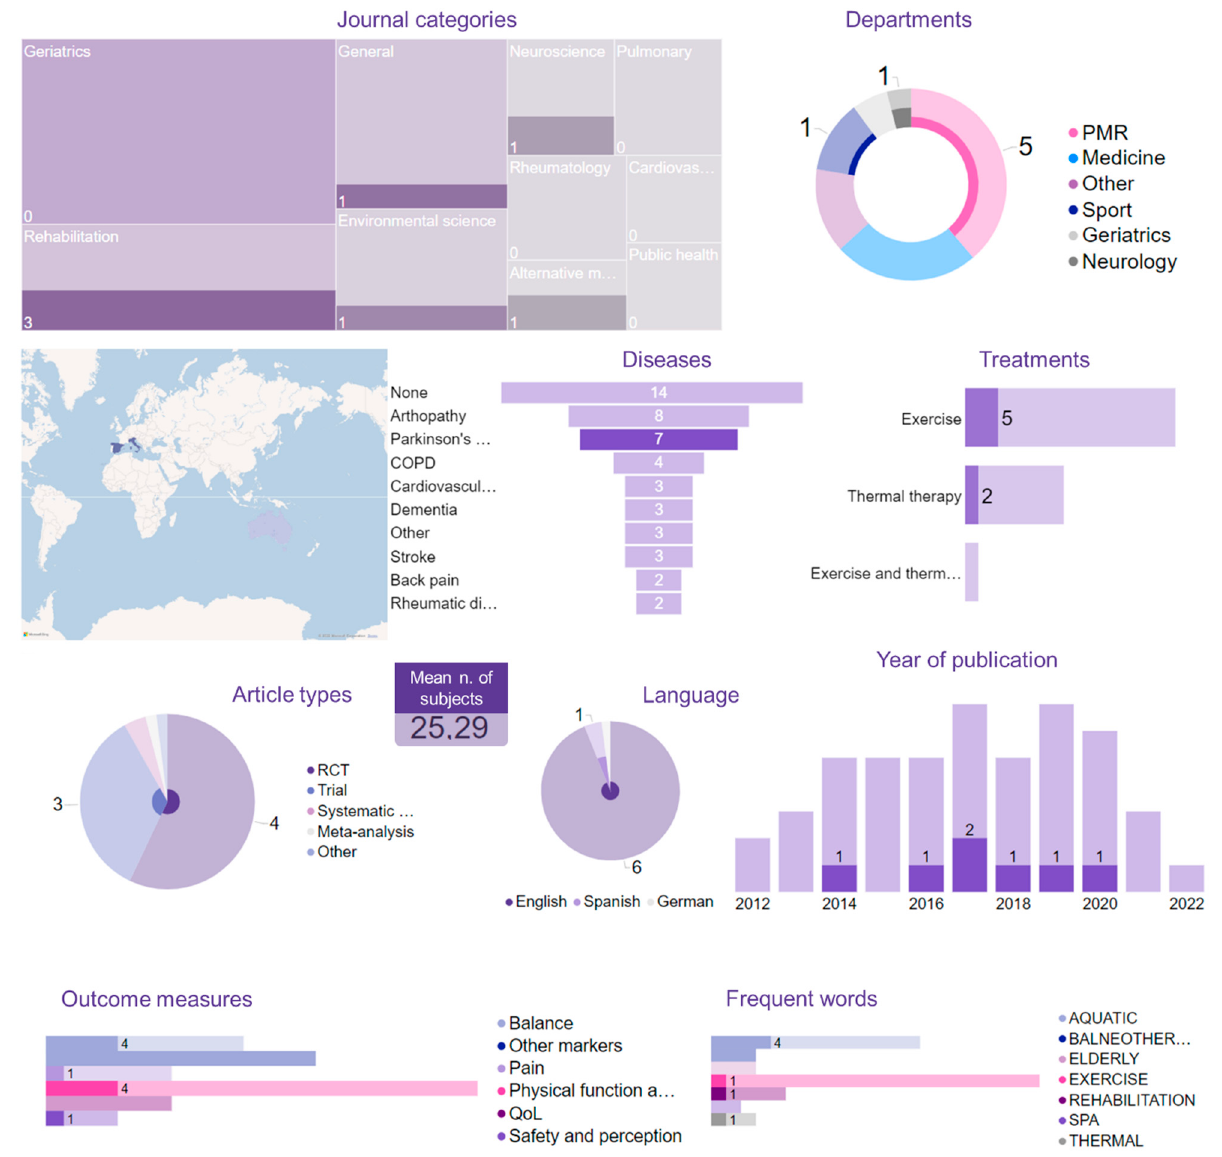
Figure 5. Results focused on the modality: “Parkinson’s disease”. By filtering the modality of the variable, the relative results of the other variables are shown (dark colors in the graphs). The shading is the pale portion of the graph, including the results not related to the selected modality.